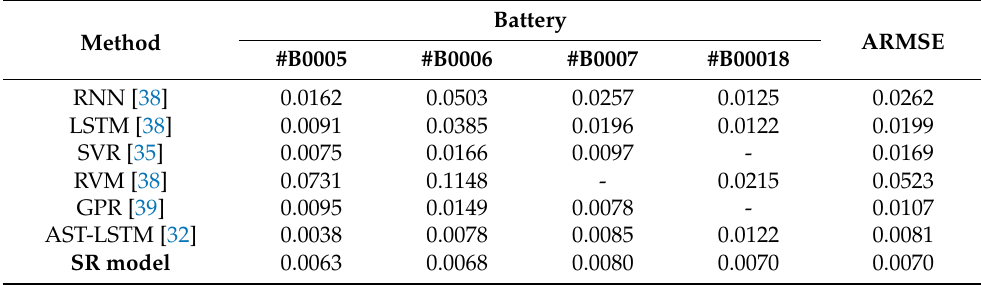
Table 5. TheRMSEsandARMSEsoftheSOHestimationusingdifferentmethodswith30% historical